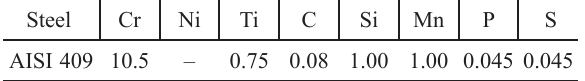
Table 1 – Chemical composition of the AISI 409 SS (wt.%)